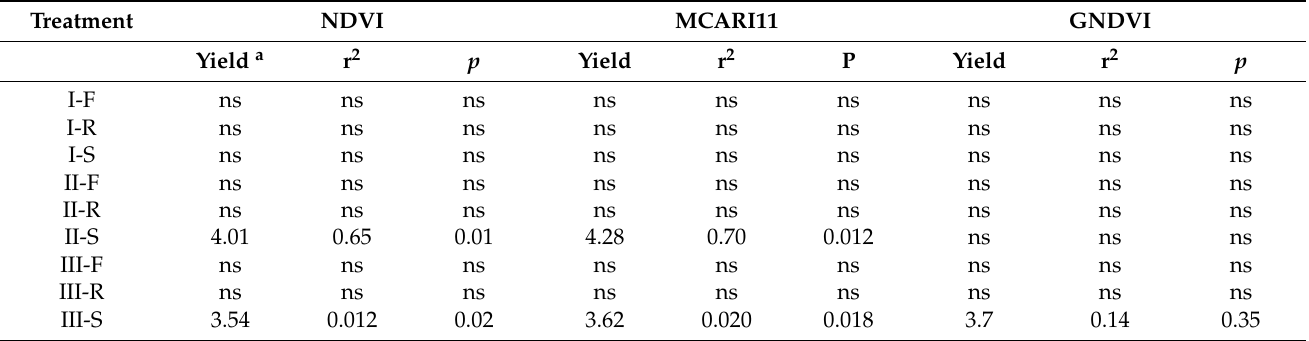
Table 8. Yield model performance based on NDVI, MCARI11 and GNDVI by treatment.